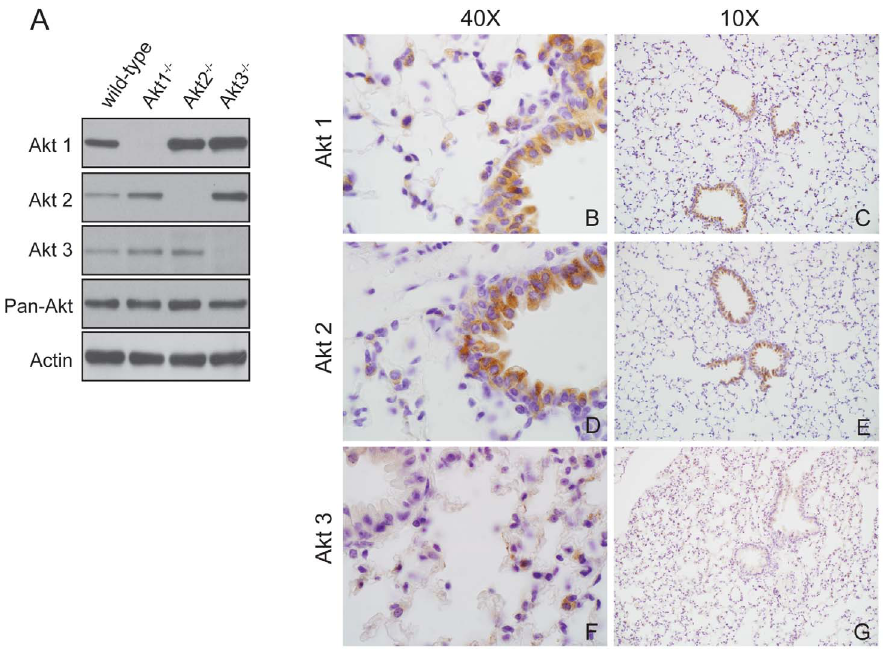
Figure 1. All three Akt isoforms are expressed in mouse lungs. (A) Representative western blot analysis of 80 ug of total protein extracted from the lungs of 8-week-old C57BL/6 mice probed with a panel of Akt isoform-specific antibodies (Akt1, Akt2 and Akt3) as well as a pan-Akt antibody. An anti-actin antibody was used to demonstrate equal loading. Immunohistochemical staining of 8-week-old C57BL/6 mouse lungs with Akt1 (B and C), Akt2 (D and E) and Akt3 (F and G) specific antibodies. (Figure 4A, D, G and J). To investigate whether Akt isoform ablation had an effect on the cellular composition of the tumor, lung sections were stained with a surfactant protein C (SPC) specific antibody as a marker for ATII cells and a Clara cell secretory protein (CC10) specific antibody as a marker for non- ciliated secretory epithelial cells lining the primary bronchioles of the lung. As with the WT mice, all lung tumors that formed in the Akt knockout mice were SPC positive (Figure 4B, E, H and K) and CC10 negative (Figure 4C, F, I and L) indicating that the tumors were of ATII cell origin. All staining with isotype control antibodies was negative (data not shown).